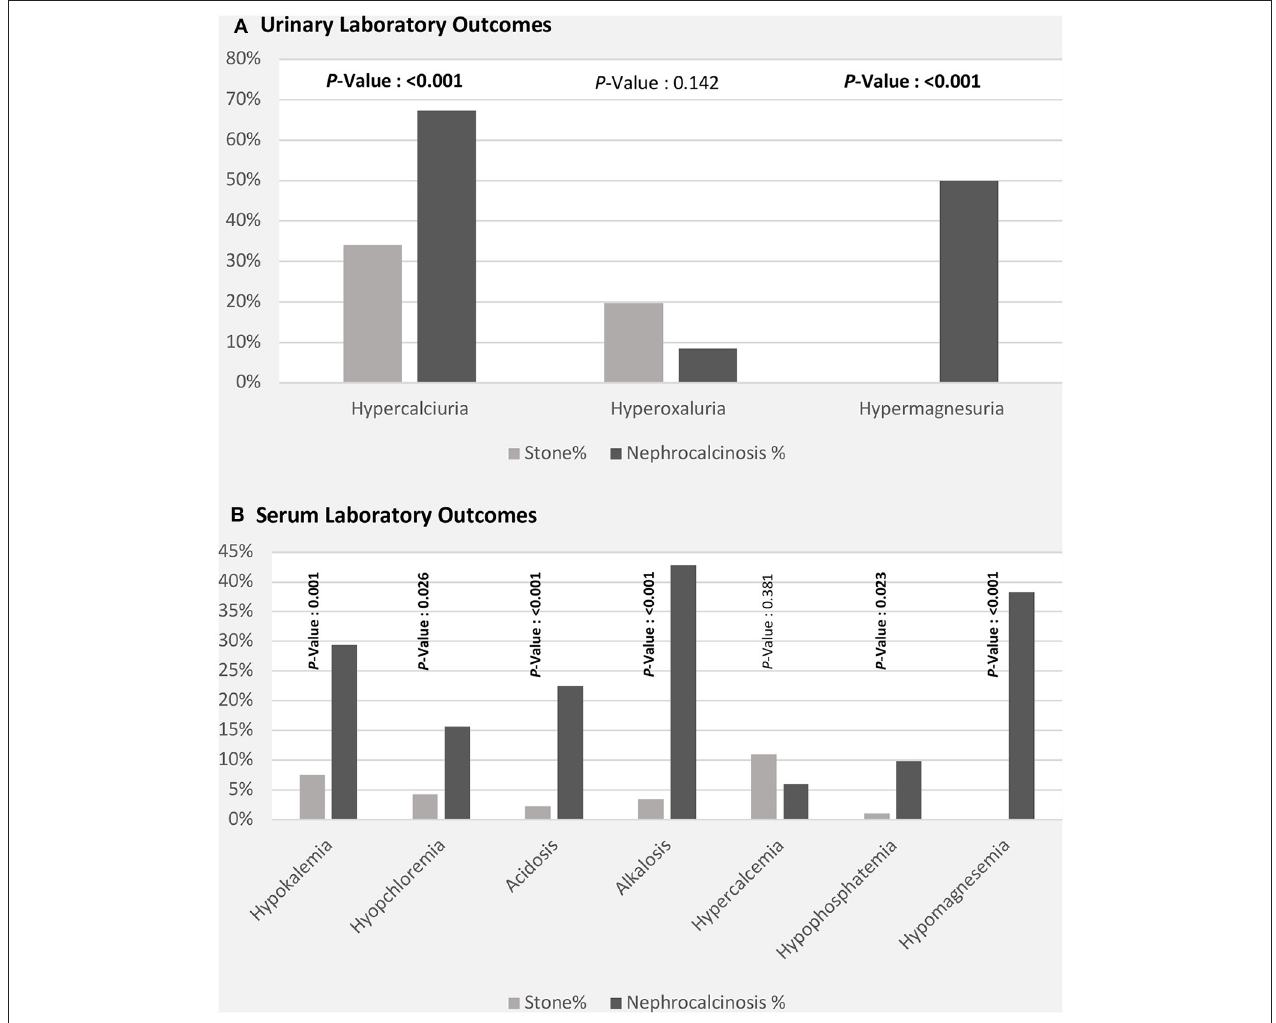
FIGURE 3 | Laboratory outcomes [urinary (A) and serum (B) ] among patients with nephrolithiasis/urolithiasis (renal stone) and